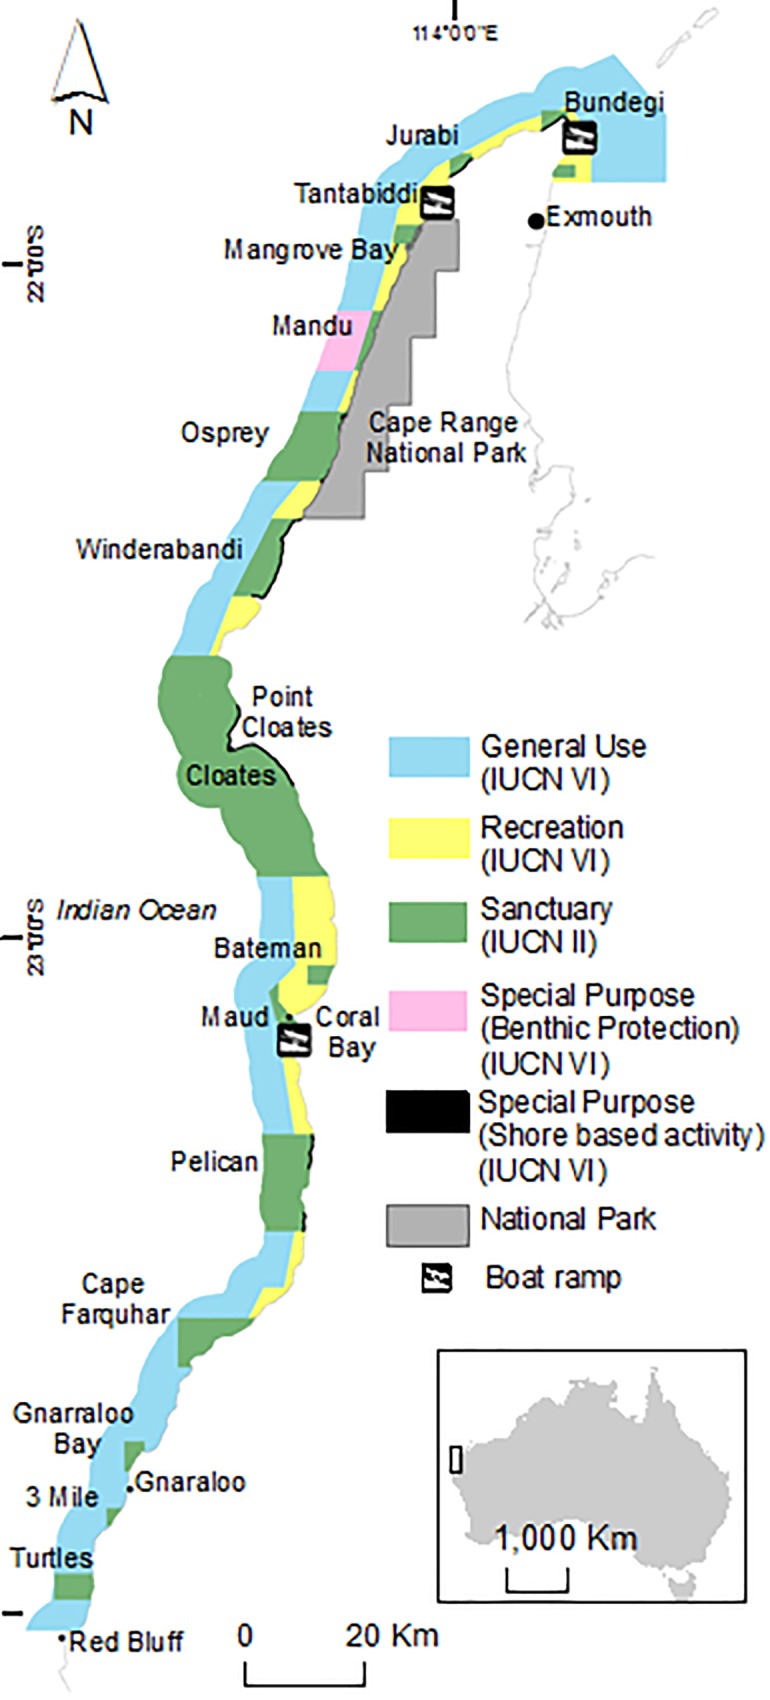
Ningaloo Marine Park indicating management zones: General Use Zone (recreational fishing and limited commercial fishing permitted, IUCN VI), Recreation Zone (recreational fishing permitted, IUCN VI), Special Purpose Zones (recreational shore-based or trolling fishing only, IUCN VI), No-take Sanctuary zones (no fishing permitted, IUCN II).